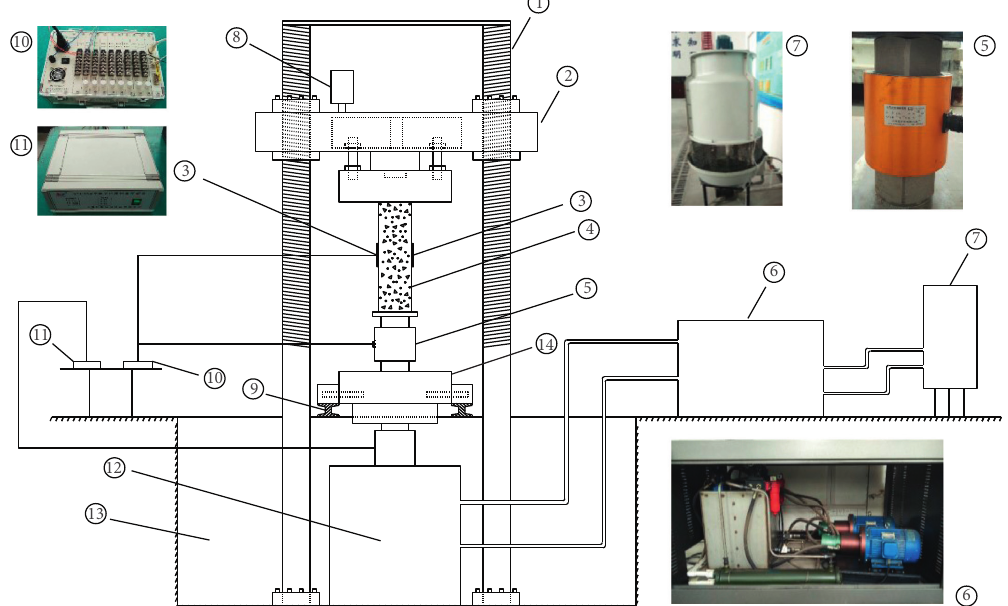
Figure 2: Electrohydraulic servocontrolled creep test system with the following components: (1) guide screw, (2) bearing plate, (3) strain gauge, (4) concrete, (5) pressure transducer, (6) oil pump system, (7) cooling tower, (8) electric machinery, (9) track, (10) strain collection device, (11) controller, (12) power device, (13) underground space, and (14) bearing plate.